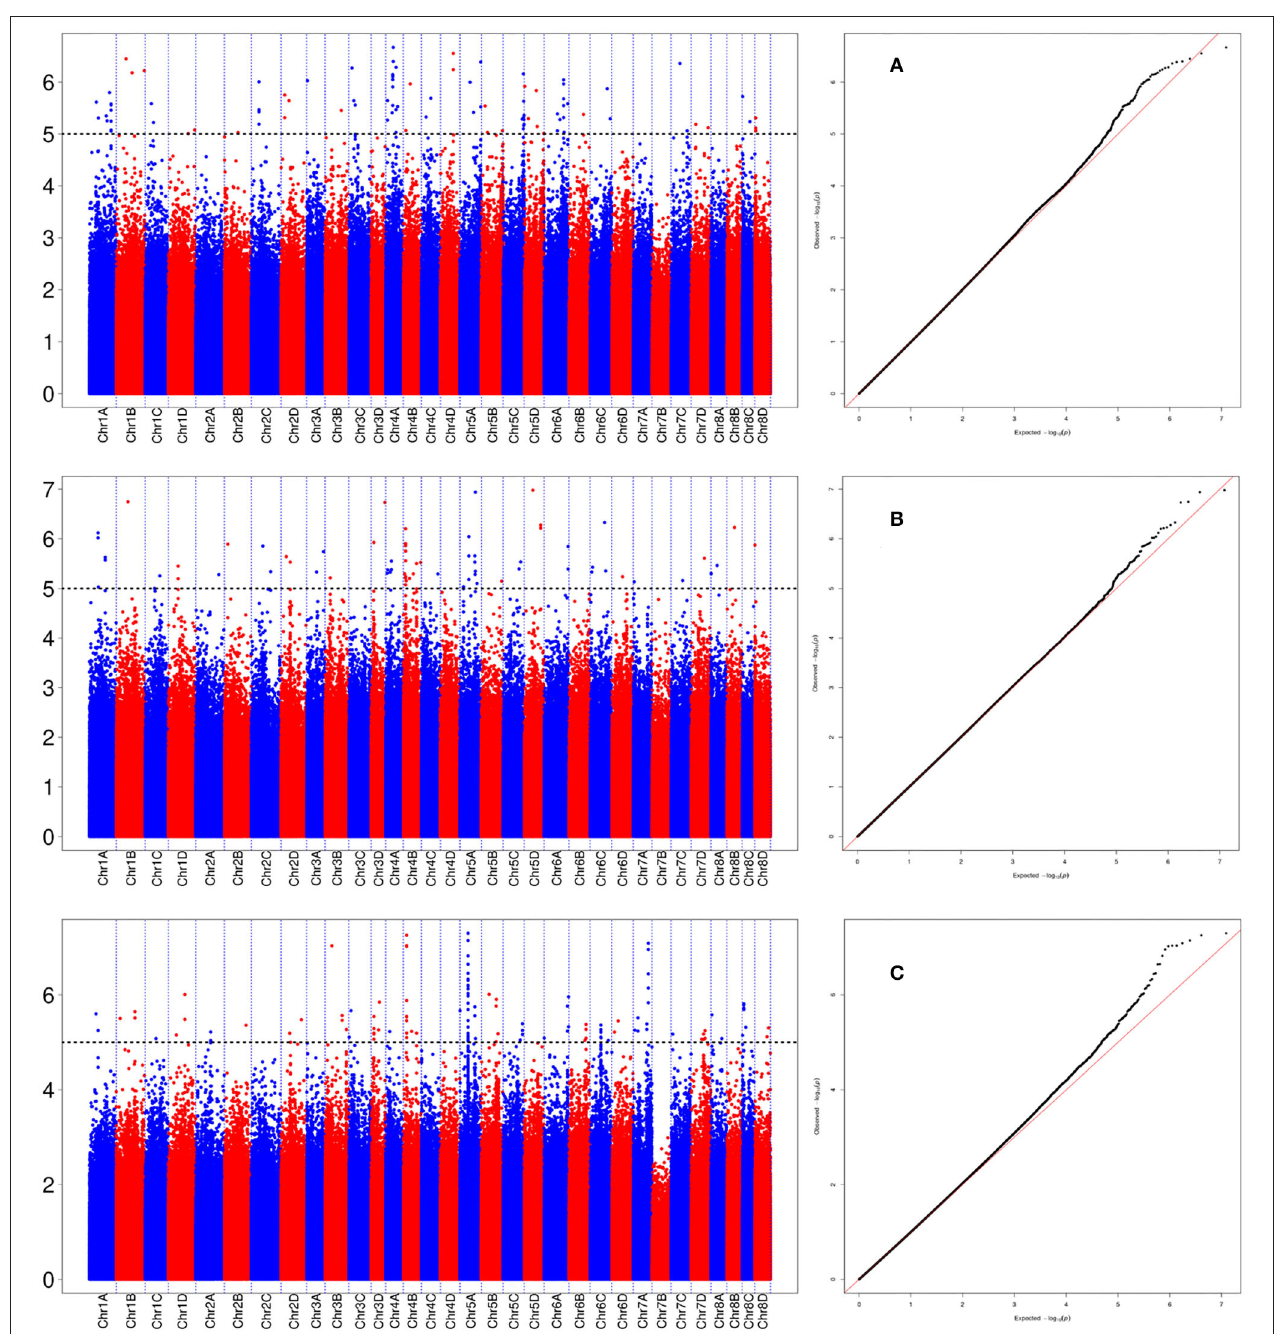
FIGURE 6 | Manhattan plot for the locus of Ss6A_102766953 in sugarcane three growth stages. (A) Denotes the + 2 leaf of the sugarcane seedling stage, (B) denotes the + 2 leaf of the sugarcane elongation stage, and (C) denotes the + 2 leaf of the sugarcane mature stage.